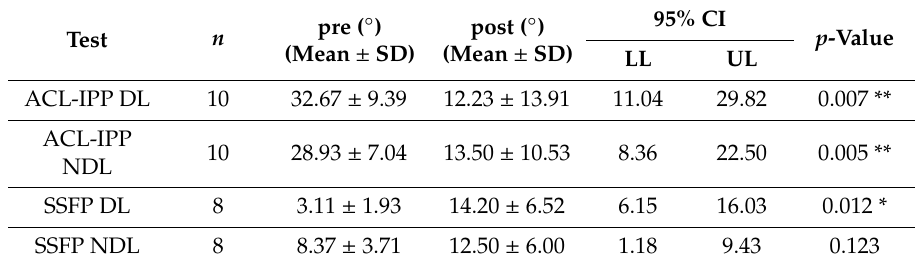
Table 1. Average pre–post intervention data in the protocols di ff erentiated by leg dominance.